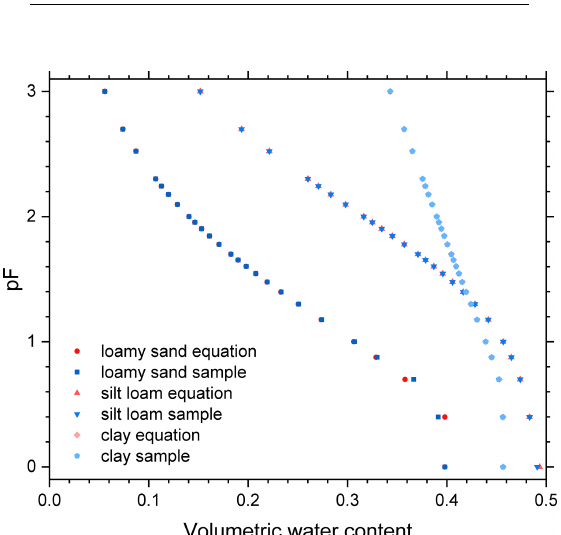
Figure C10. Soil water retention points calculated from RIA pa- rameterizations for loamy sand (UNSODA identifier 2104, classi- fied according to Twarakavi et al., 2010; A4), silt loam (3261; B2), and clay (1181; C4). The points were either calculated directly for the given pF value (“equation”), or by calculating the average wa- ter content in a sample of 5.0cm height at hydrostatic equilibrium, with the matric potential at the centre of the sample corresponding to the indicated pF value (“sample”). Note: the data points for zero matric potential were plotted at pF = 0 instead of pF =−∞